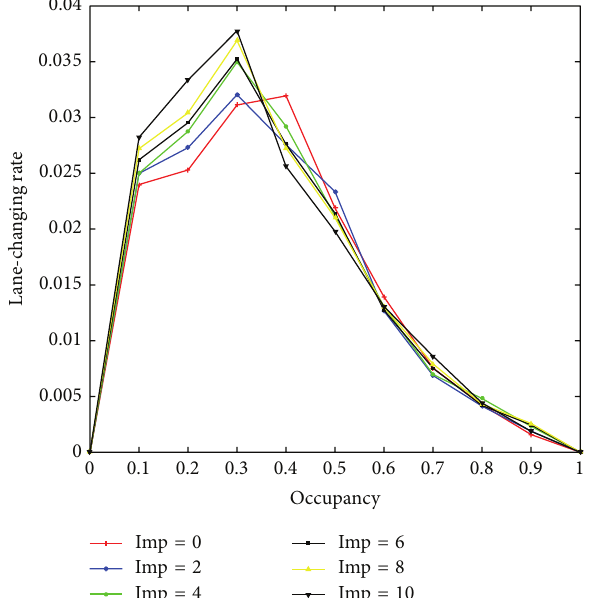
Figure 7: Lane-changing rate of passenger cars with different imp when 𝑟 = 0.2 .